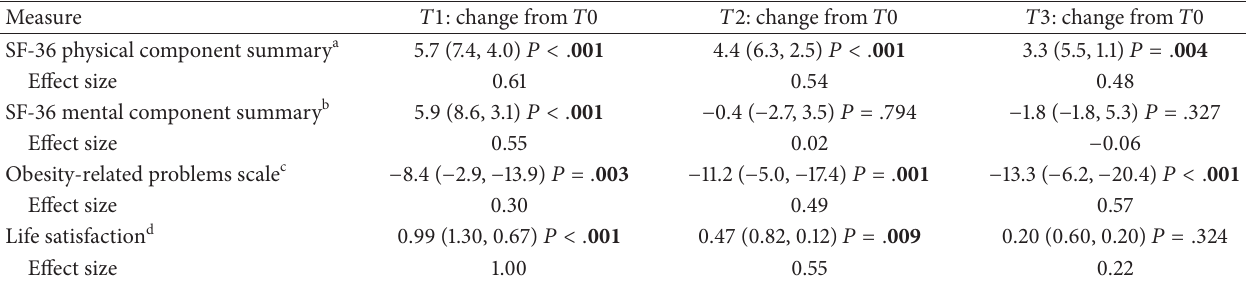
Table 2: Mixed-effect model estimates: mean changes (95% CI) in quality of life outcomes during the two-year lifestyle intervention for severely obese adults.